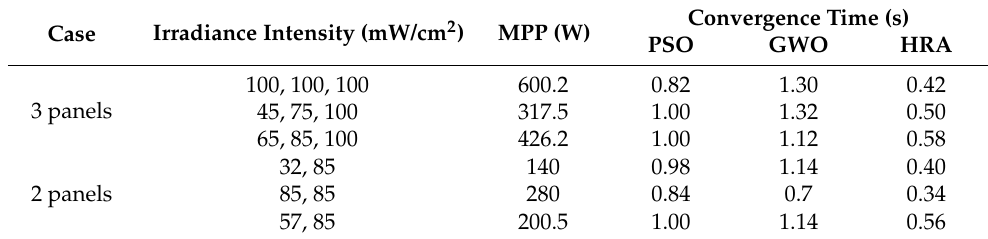
Table 4. Comparison of simulation results between three MPPT methods for two cases.